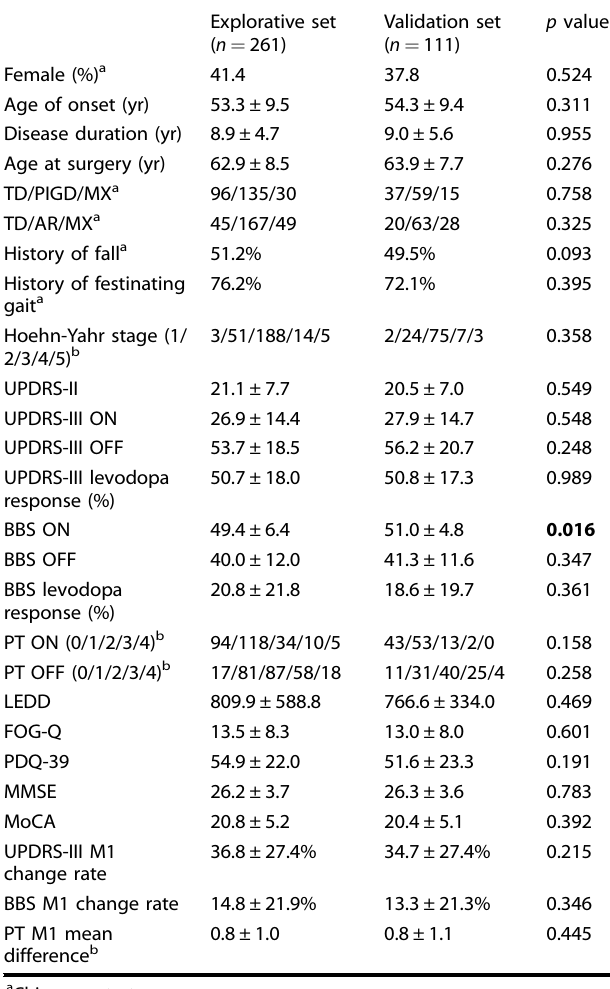
Table 1. Baseline characteristics and improvement at M1 in the explorative and validation